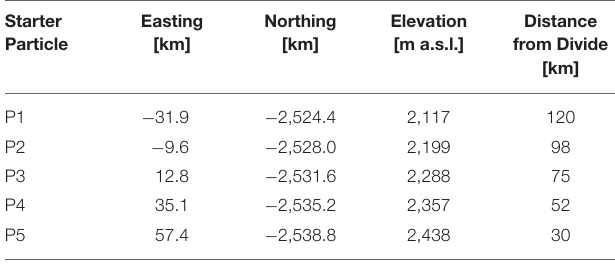
TABLE 1 | Initial coordinates, elevation, and distance from the ice divide of simulated